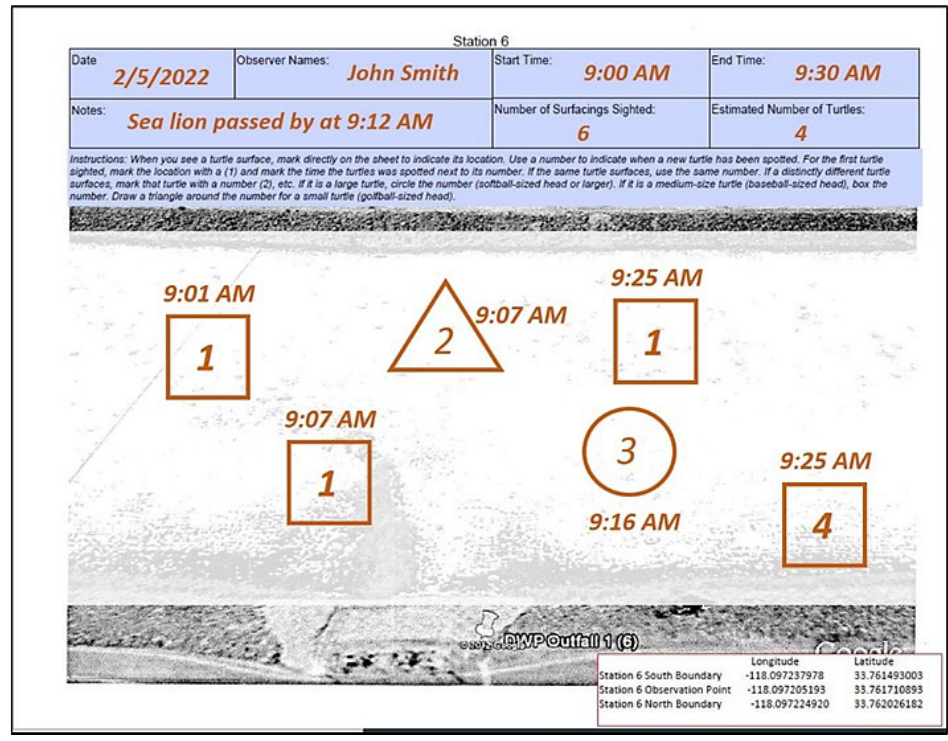
Figure 4. Example Observation Log.